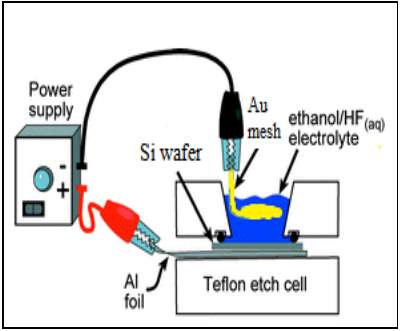
Fig. 1: Cross section of electrochemical etching.